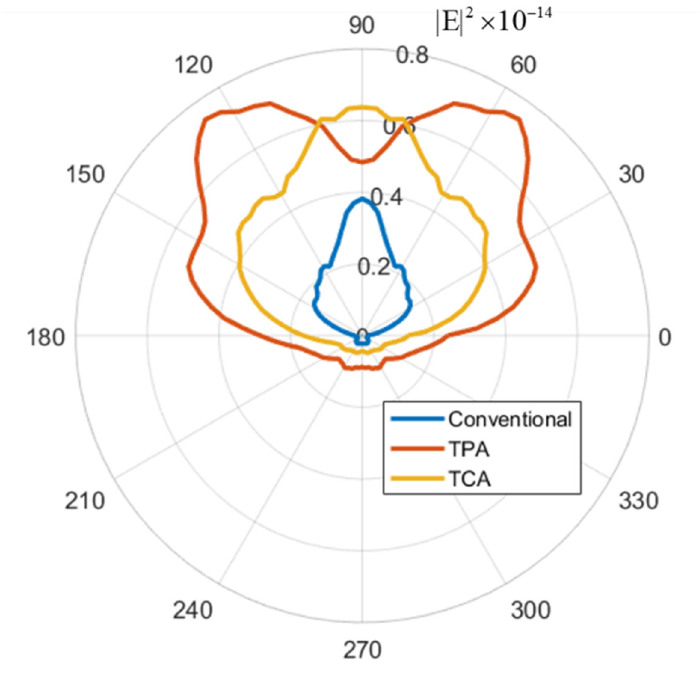
Figure 5. Far-field distribution of the LEDs with three Figure 5. Far ‐ field distribution of the LEDs with three structures.